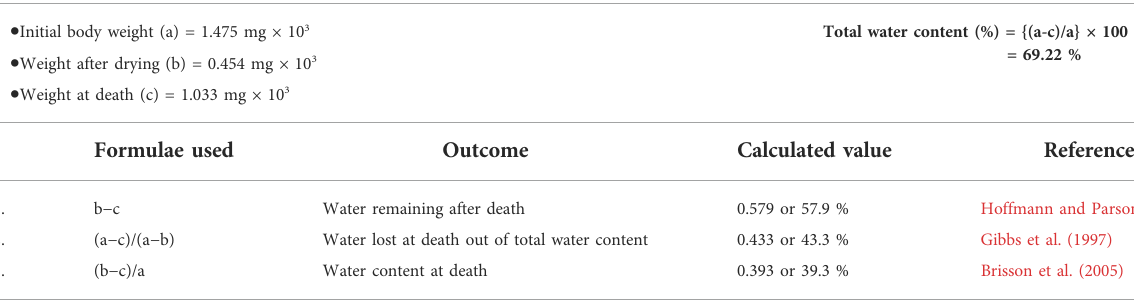
TABLE 1 Summary of calculations used from different physiologists for estimating dehydration tolerance. Assumption for Standardising the